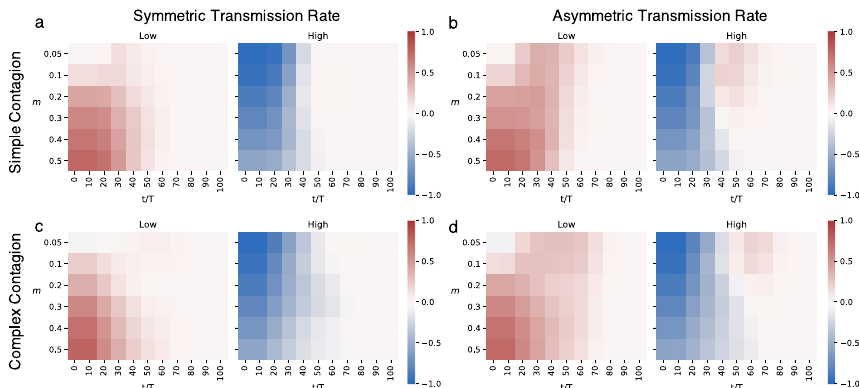
Fig. 5 Information spreading equality for homophily BA with different minority portions m . The influence of m on information access equality is strongly dependent on the minority seeding portion and is independent of contagion type and transmission rate. At low minority seeding portion, more equality is achieved with the lowest m (0.05 in our